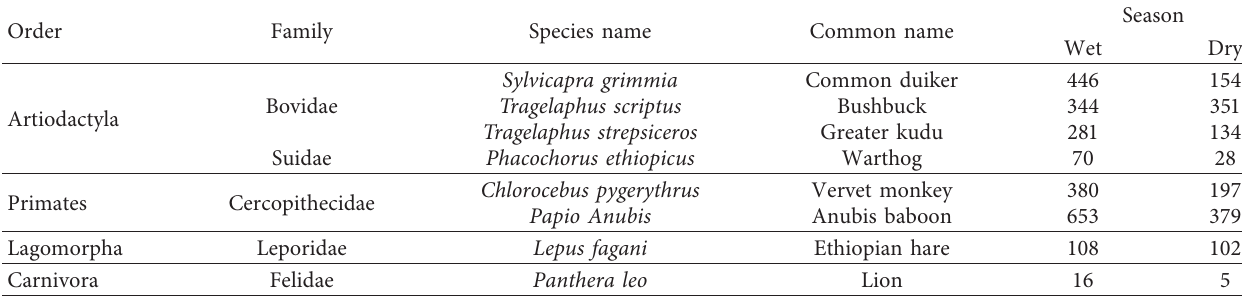
Table 5: Abundance of mammalian species based on their taxonomic category.